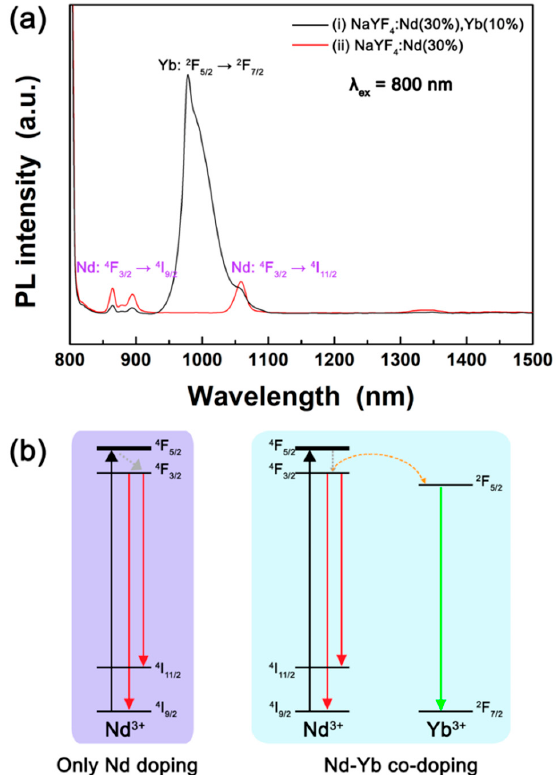
Figure 1. ( a ) PL spectra of (i) NaYF 4 :Nd (30%),Yb (10%) and (ii) NaYF 4 :Nd (30%) core DSNPs under 800 nm NIR light. ( b ) Schematic energy level diagram showing electronic transitions in Nd 3+ -doped and Nd 3+ and Yb 3+ co-doped DSNPs.